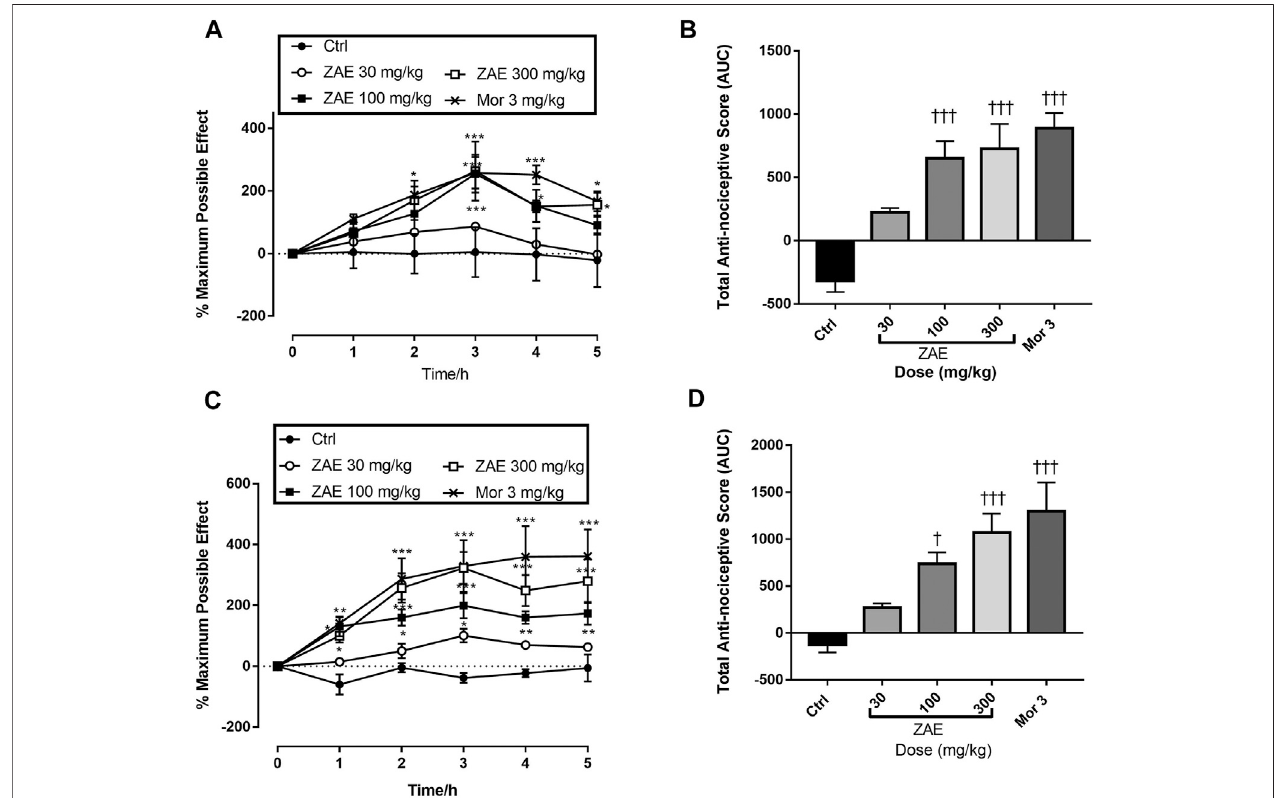
FIGURE 4 | Effect of the three doses of ZAE and morphine on the (A) percentage maximum possible effect and (B) total anti-nociceptive effect in acute musculoskeletal pain in rats. The fi gure also shows the effect of the three doses of ZAE and morphine on the (C) percentage maximum possible effect and (D) total anti- nociceptiveeffectinchronicmusculoskeletalpaininrats.Thesymbols* p < 0.05;** p < 0.01;*** p < 0.001denotesigni fi cantdifferencesintime-coursecurvesoftreatment compared to the control (Ctrl) group (two-way ANOVA followed by Dunnet ’ s multiple comparison test) whereas † p < 0.05, †† p < 0.01, ††† p < 0.001 denote signi fi cant differences of treatment in comparison with control (Ctrl) group using the one-way ANOVA followed by Tukey ’ s multiple comparison test.